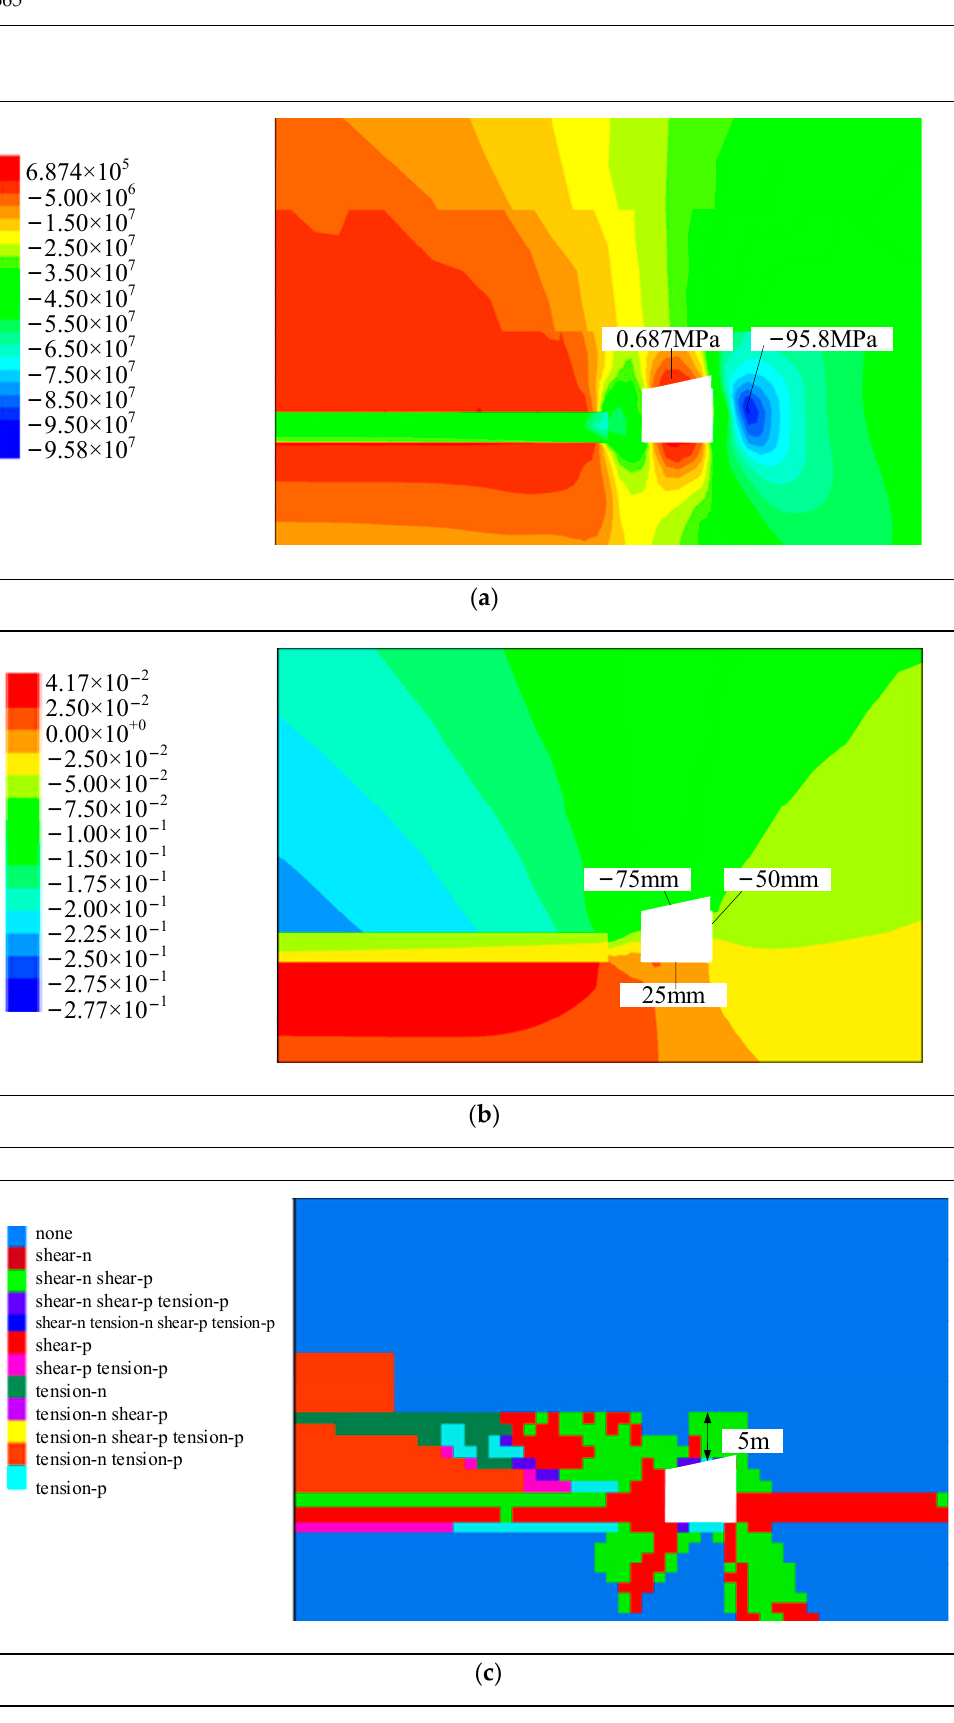
Figure 5. Tertiary support simulation results, ( a ) vertical stress distribution diagram, ( b ) vertical displacement distribution map, ( c ) distribution diagram of the plastic zone.